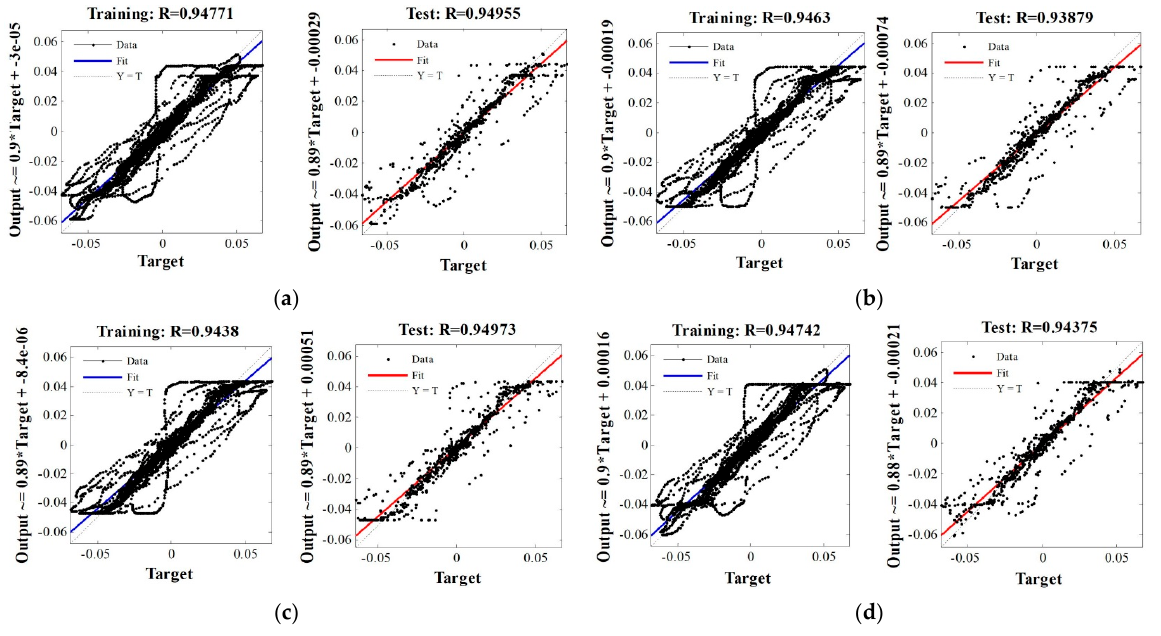
Figure 8. Pattern recognition based regression diagram for feed-forward backdrop using ( a ) Bayesian Regulation, ( b ) Polak-Ribiere Restarts, ( c ) Gradient Descent with momentum and adaptive learning rate, and ( d ) Levenberg-Marquardt Algorithm.